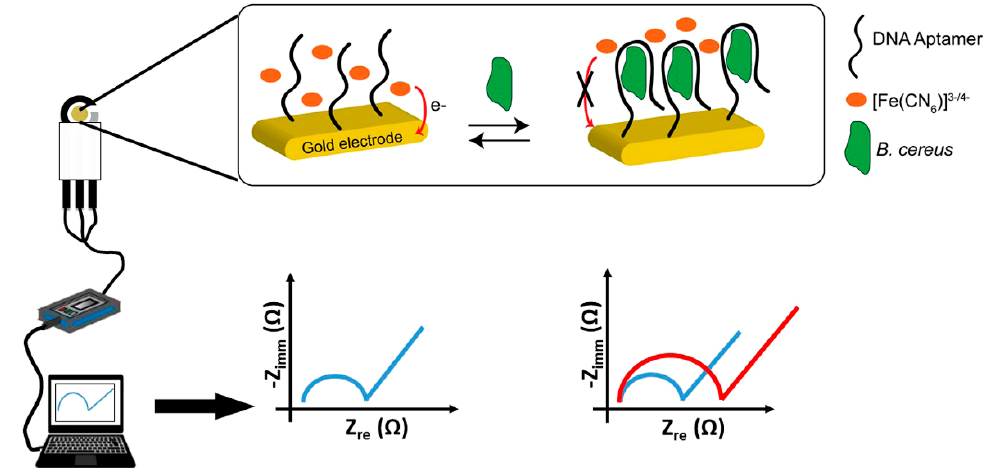
Figure 4. Illustration of principle for B. cereus spore detection and electrochemical set-up for signal measurement using a miniaturized aptasensor (from Reference [97] ).